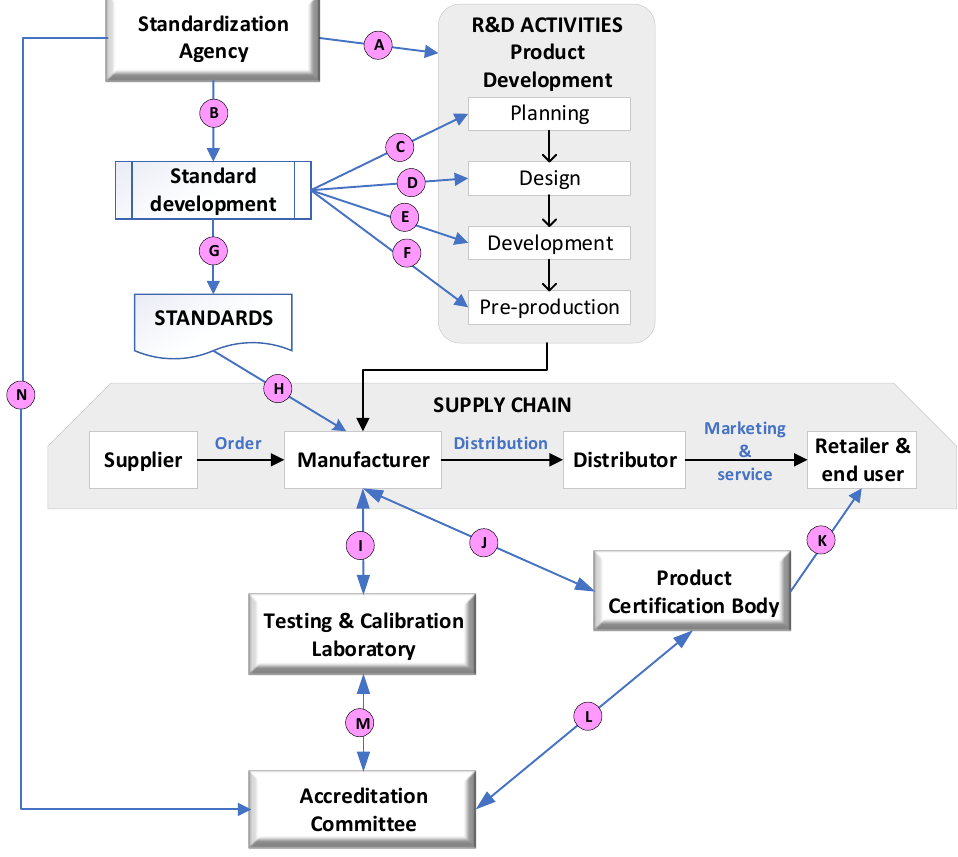
Figure 12. Early standardization scheme.